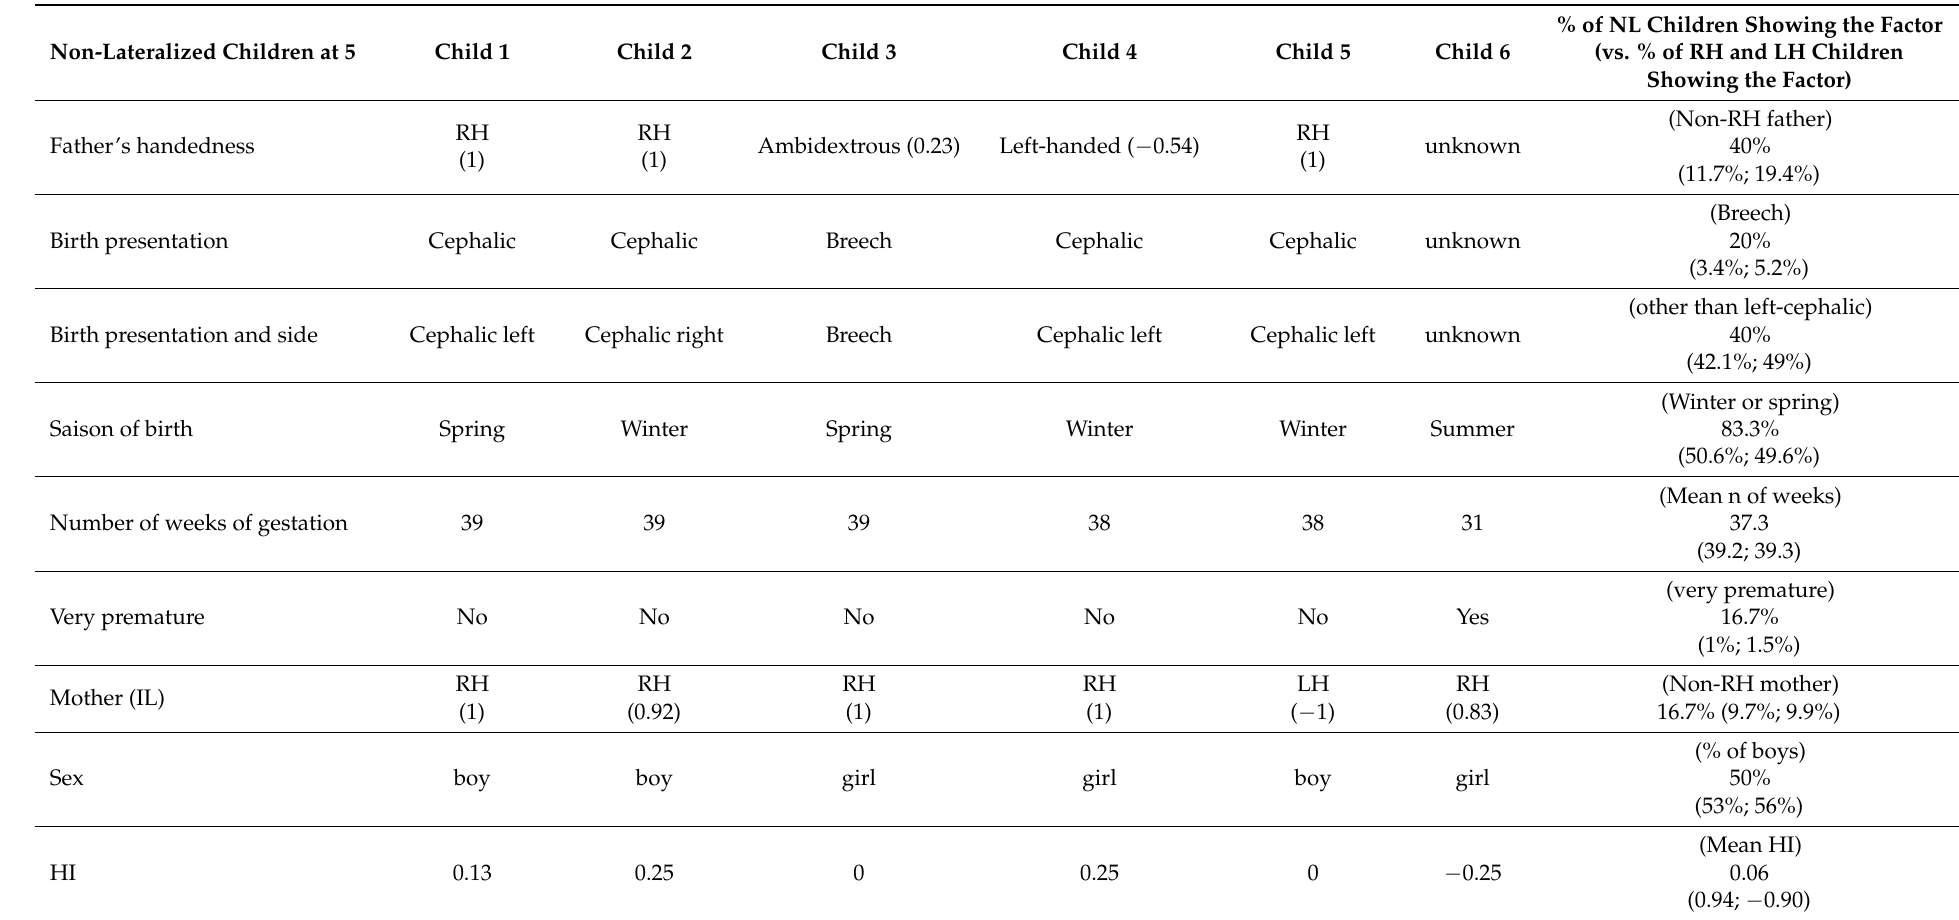
Table 3. Description of the six non-lateralized children in relation to the prenatal